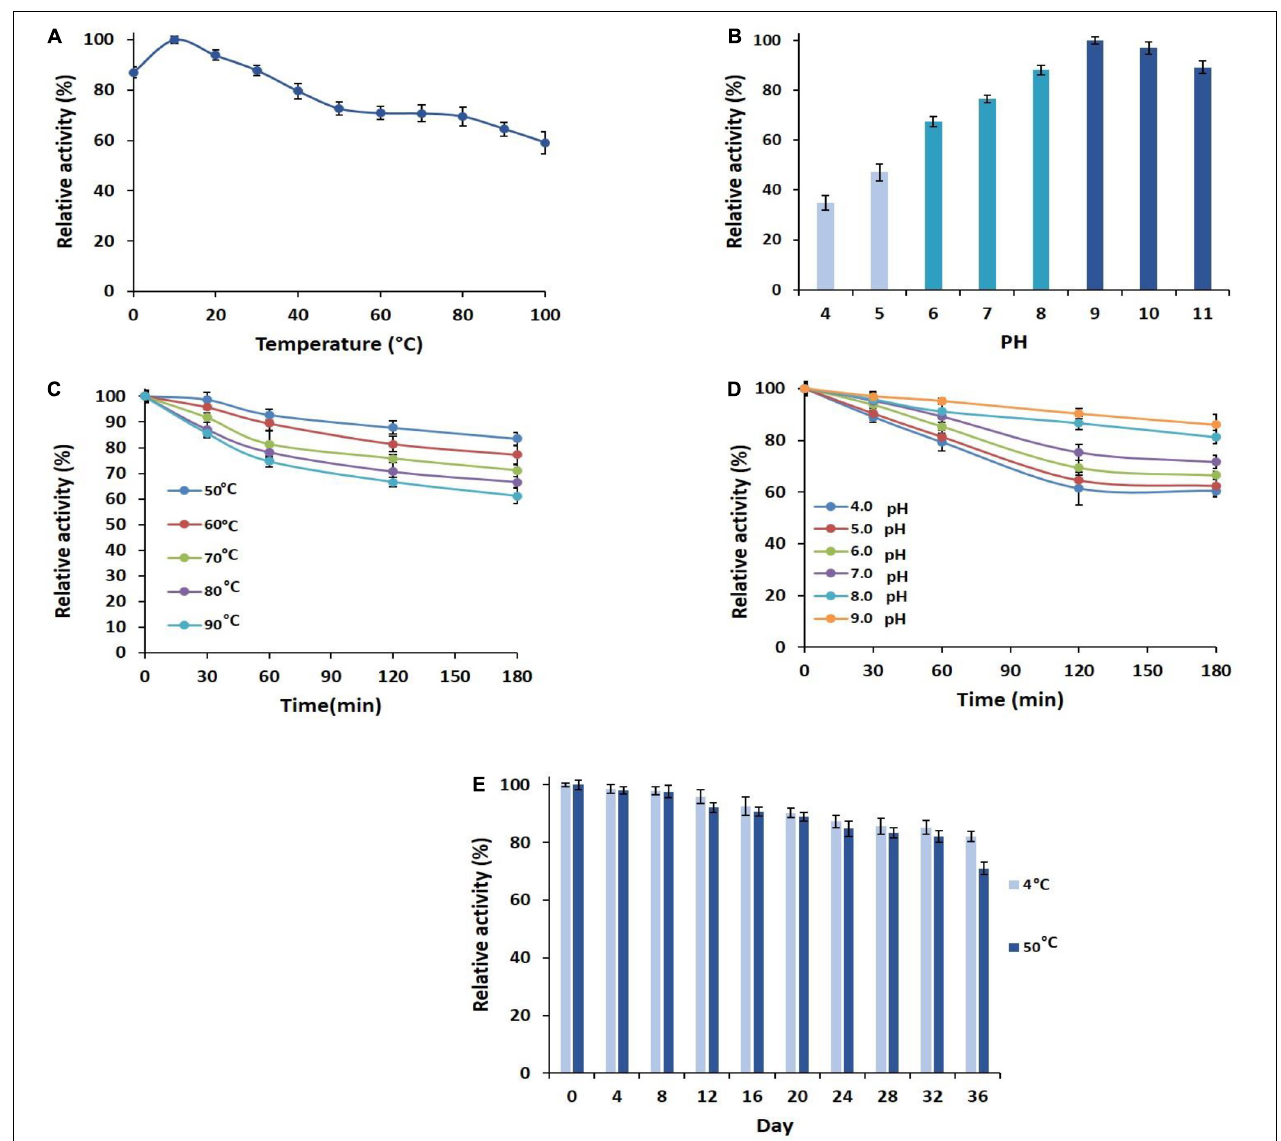
FIGURE 2 | Characterization of PersiAmy1. (A) Effect of temperature on the activity of PersiAmy1. (B) Effect of pH on the activity of PersiAmy1 using carbonate-bicarbonate buffer (pH 4.0–5.0), phosphate buffer (pH 6.0–8.0), and Tris–HCL buffer (pH 9.0–11.0). (C) Thermostability of PersiAmy1 on